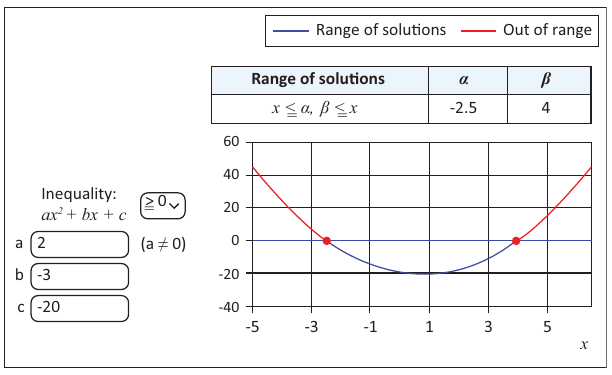
FIGURE 2: Visualisation of the solution set for Q2 generated using a graphing